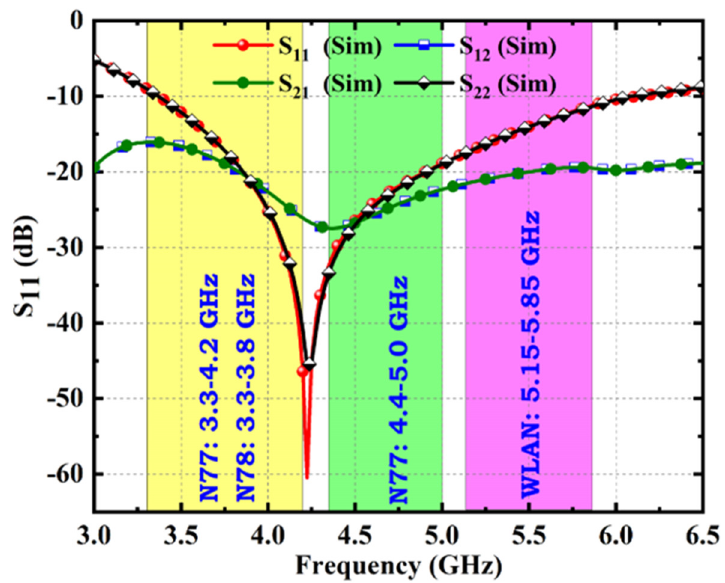
Figure 2. S–parameters response.